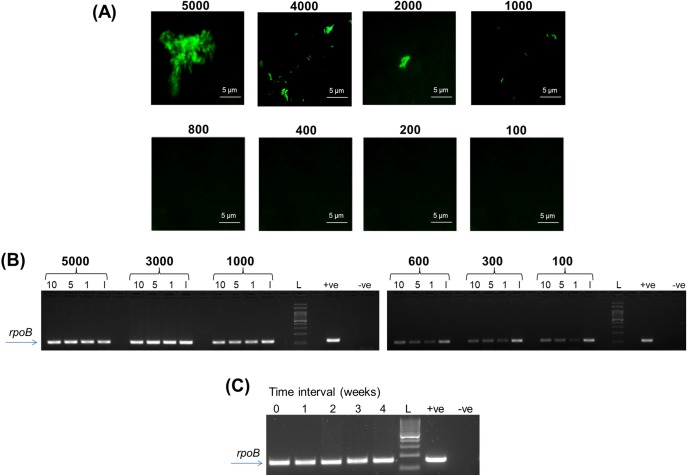
(A) Limit of Detection of BioFM-Filter microscopy (40x magnification); (B) PCR amplification of DNA isolated from Trans-Filter. 10, 5, 1 indicate the amount of DNA (in μl) added in PCR and I indicates inhibitor check reaction. Numbers in panels (A) and (B) indicate the number of M. tuberculosis bacteria spiked in 1 ml of sputum; (C) Assessment of stability of DNA on Trans-Filter. Well 0 represents amplification of freshly isolated DNA (day 0) and wells 1 to 4 represent amplification of DNA isolated from Trans-Filters stored at 50ºC at weekly intervals upto 4 weeks. Data for a scanty smear grade sputum sample is shown.